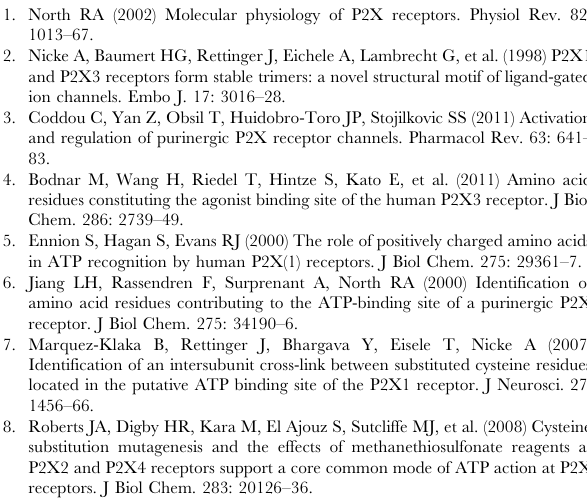
Figure S2 Responsiveness of the WT and mutant receptors to ATP analogue agonists. (A) Concentration